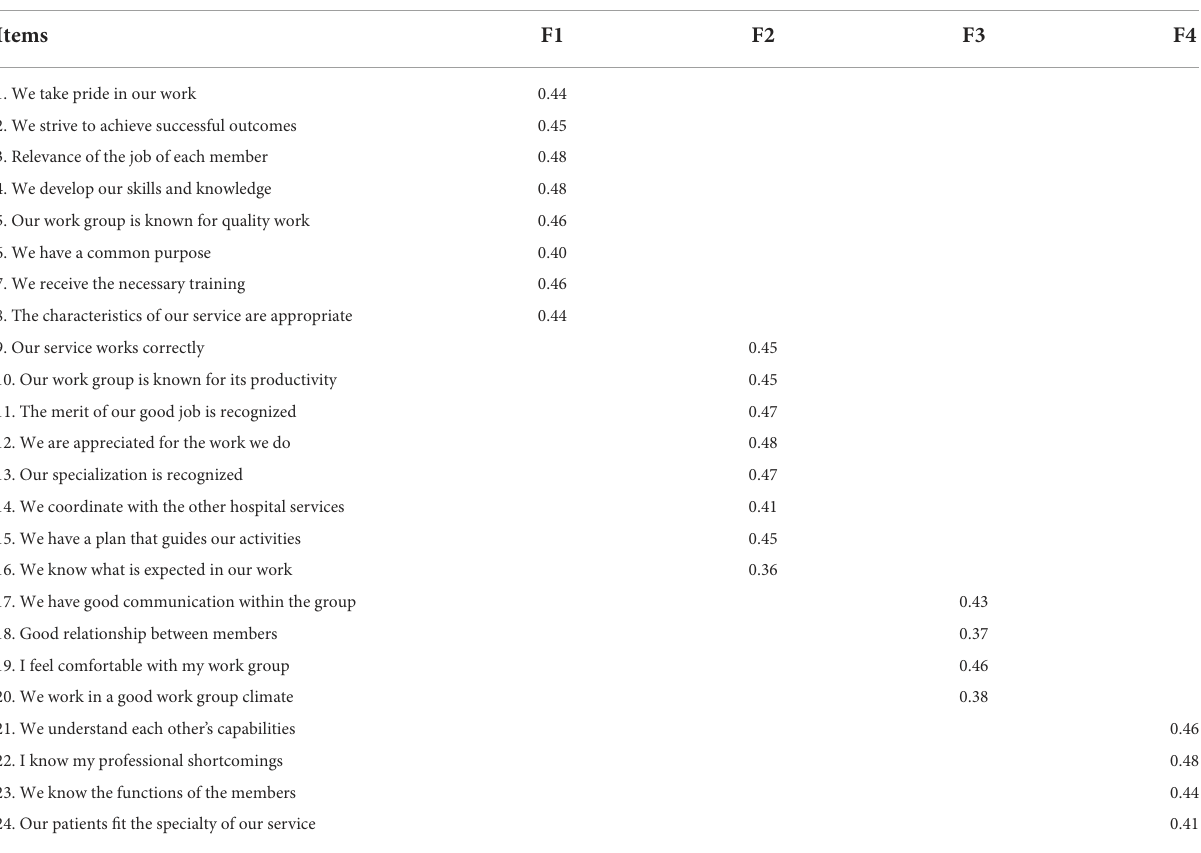
TABLE 5 Standardized factors loadings obtained in the Confirmatory Factor Analysis, CFA. Abridged Version (24